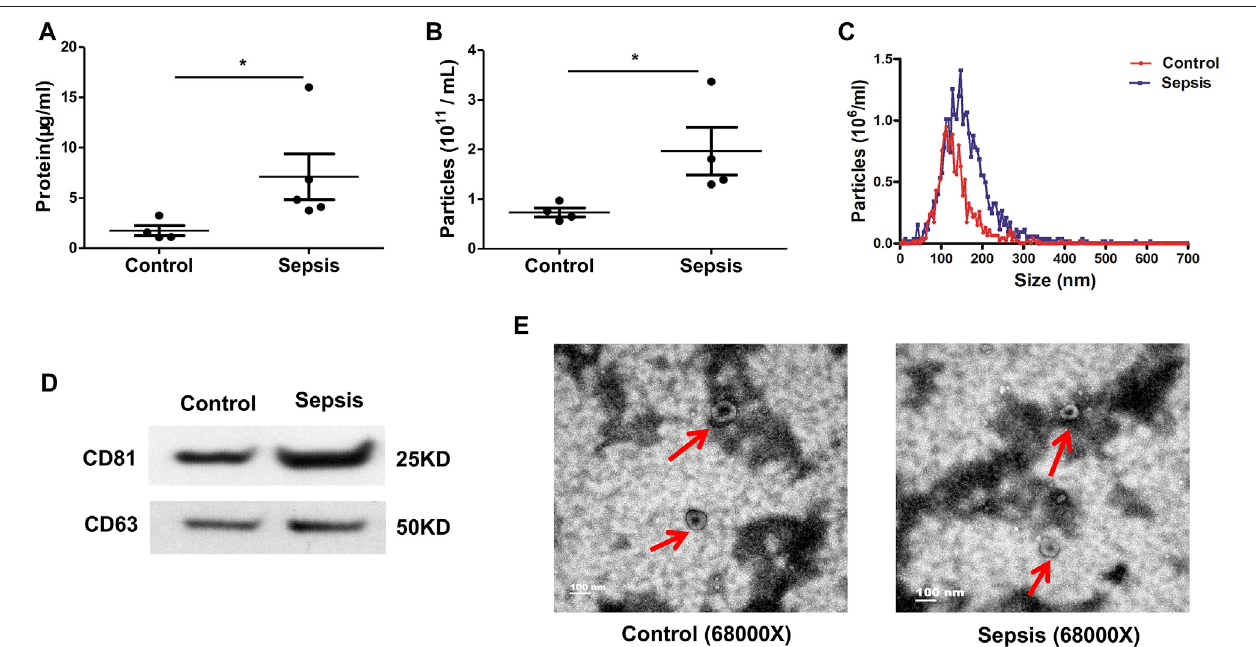
FIGURE 1 | Characteristics of plasma-derived extracellular vesicles (EVs). Plasma-derived EVs were isolated from the plasma of sepsis patients and healthy controls via differentialultra-centrifugation. (A) BCAProteinAssayKitwasusedtoquantifythetotalprotein levelsoftheEVsisolatedfromplasma. (B,C) Particlenumber and size distribution of EVs were analyzed via nanoparticle tracking analysis. (D) Plasma-derived EVs were assayed for expression of CD63 (band size of 25 – 60 kDa in literature depending on glycosylation) and CD81 (25 kDa) via Western blot. (E) Morphology of plasma-derived EVs was imaged by transmission electron microscopy. Data are presented as mean ± SD. n = 4 – 5. * p <